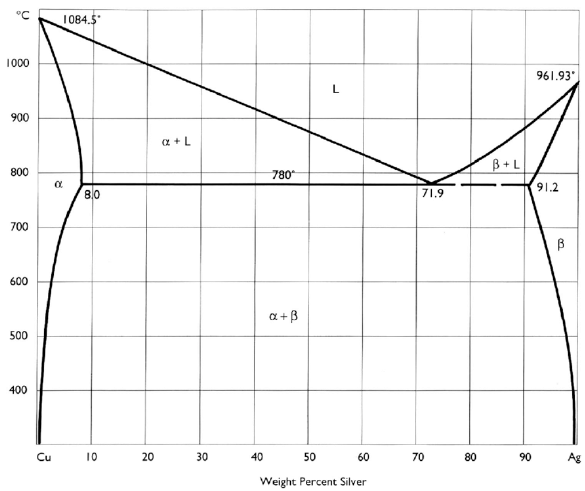
Figure 10. Ag–Cu phase diagram. Reproduced with permission from Reference [251]. Copyright 1991, J. Paul Getty Trust.